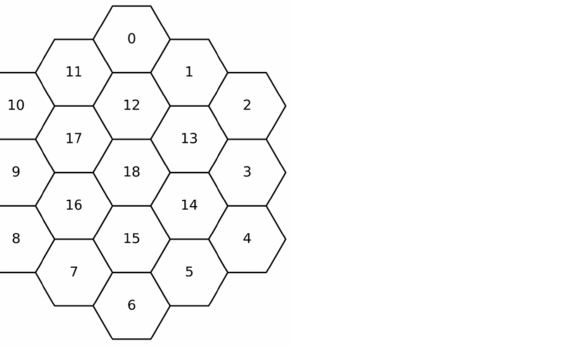
Figure 3. MPI process numbering of a 3-ring 19-assembly hexagonal